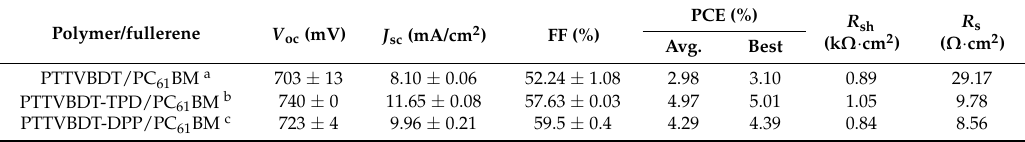
Figure 6. ( a ) J–V curves ( b ) IPCE spectra of optimized polymer/PC 61 BM devices under the illumination of AM 1.5G, 100 mW · cm − 2 . Table 3. Photovoltaic properties of polymer solar cell devices based on the polymers, PTTVBDT, PTTVBDT-TPD, and PTTVBDT-DPP, with optimized ratios of PC 61 BM under the illumination of AM 1.5G, 100 mW · cm − 2 .